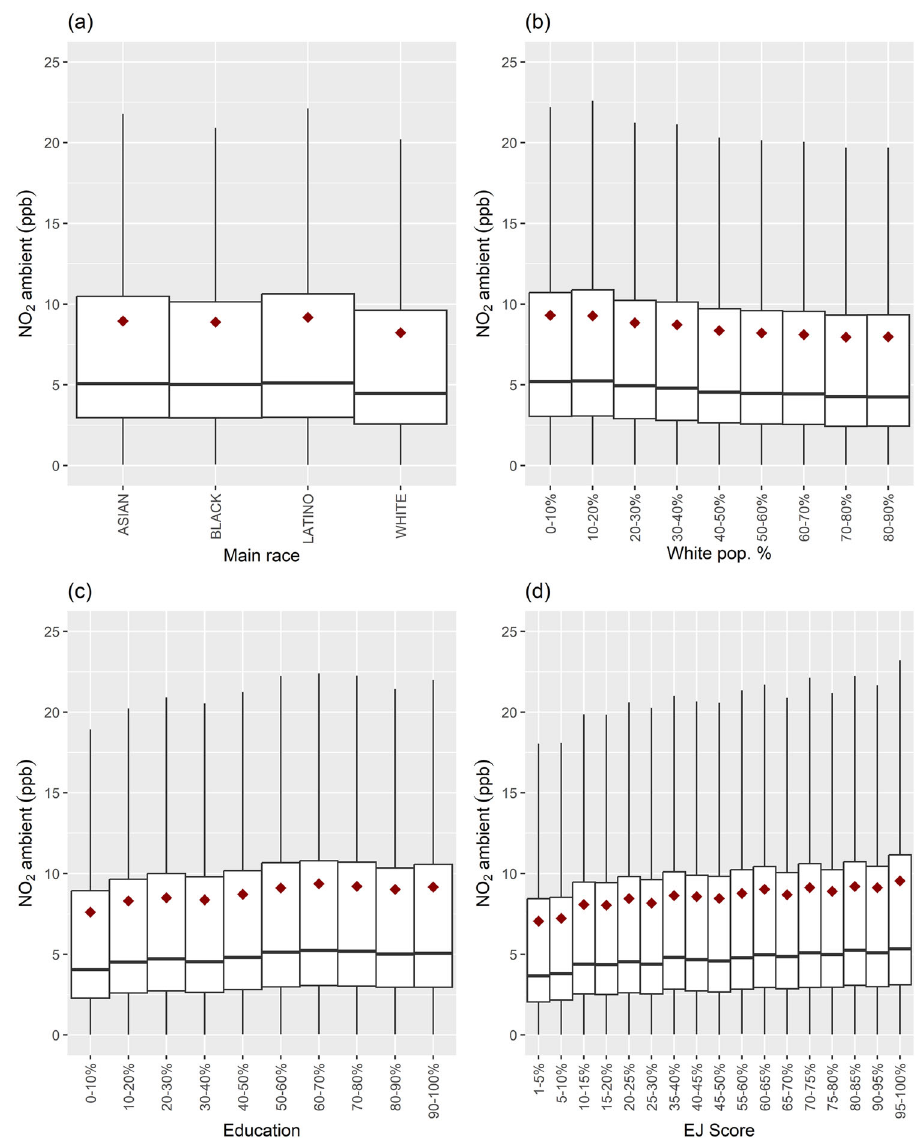
Fig. 4 NO 2 concentrations grouped by CalEnviroScreen EJ parameters for the Reference Case. EJ parameters include ( a ) race, ( b ) white population percentage, ( c ) percent of population with a degree lower than high school, and ( d ) the fi nal score in CalEnviroScreen. Diamonds represent mean concentrations, and the horizontal lines represent the median. Boxes are bound by 25% and 75% ranges. The whiskers extend to 1.5 times of the inter quartile range (IQR) from the